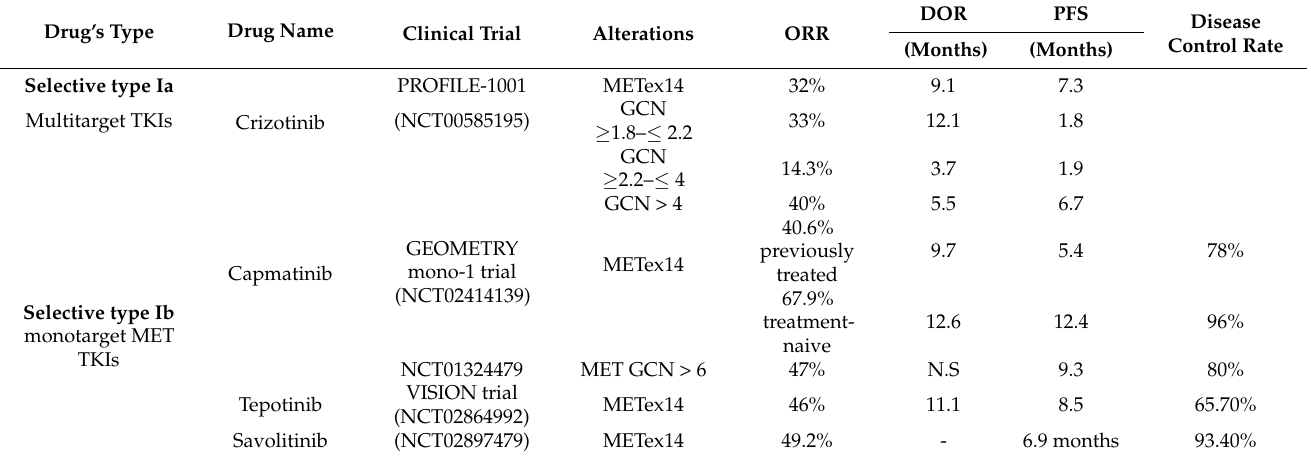
Table 2. Classification of current MET target therapies, and clinical trial results, approved by